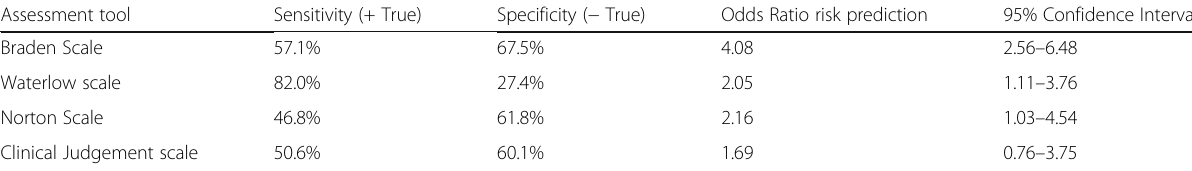
Table 1 Comparison of Braden, Waterlow, Norton, and Clinical Judgment tools Assessment